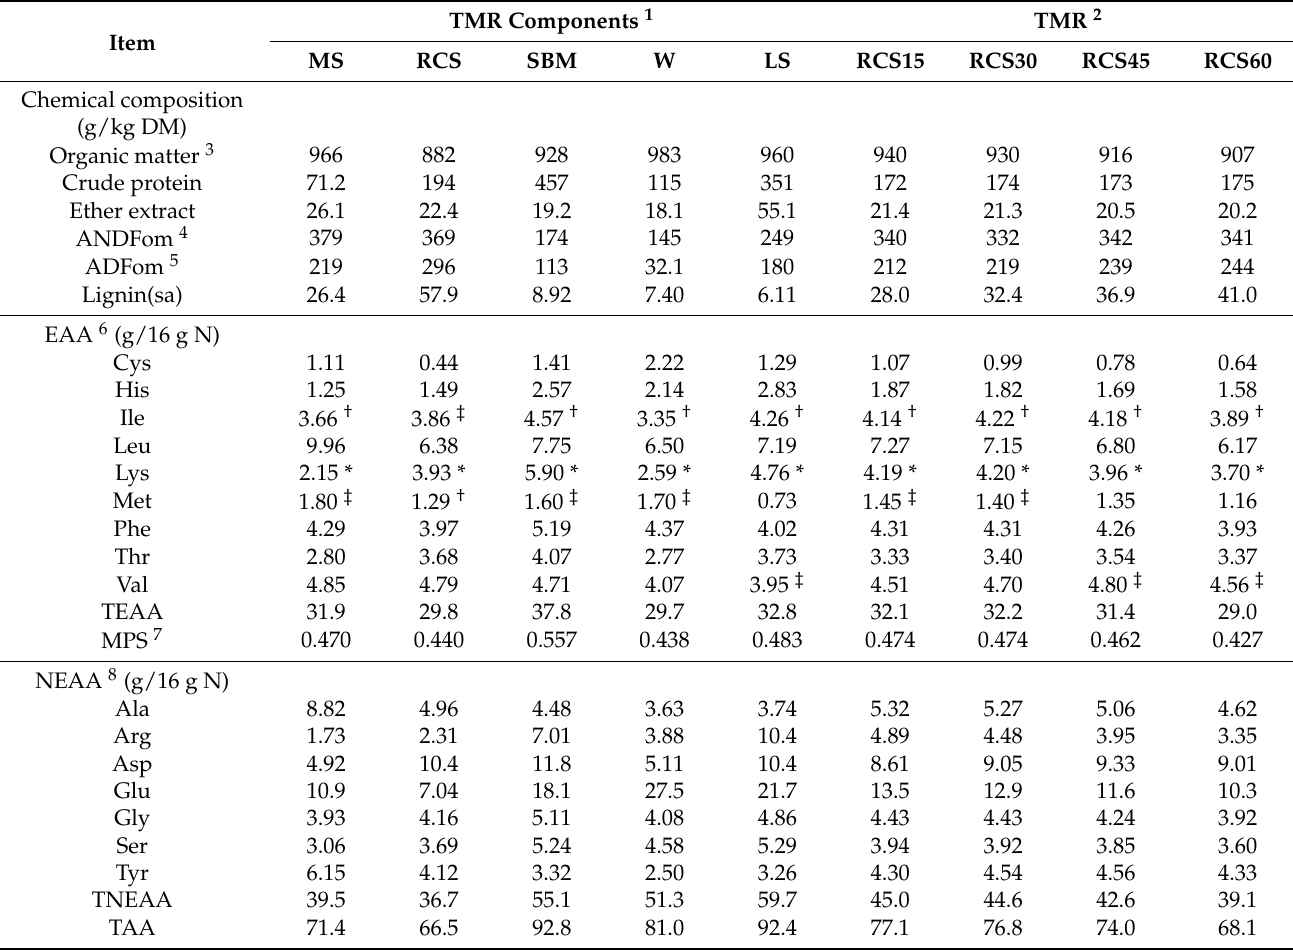
Table 2. Chemical composition and concentration of amino acids (AAs) of individual feeds and total mixed rations (TMR).